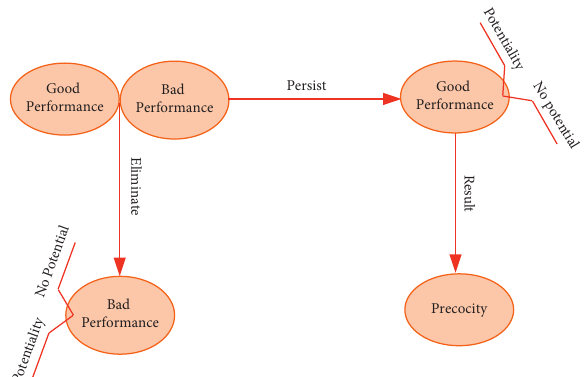
Figure 2: The demonstration for genetic optimization algorithm of the elite